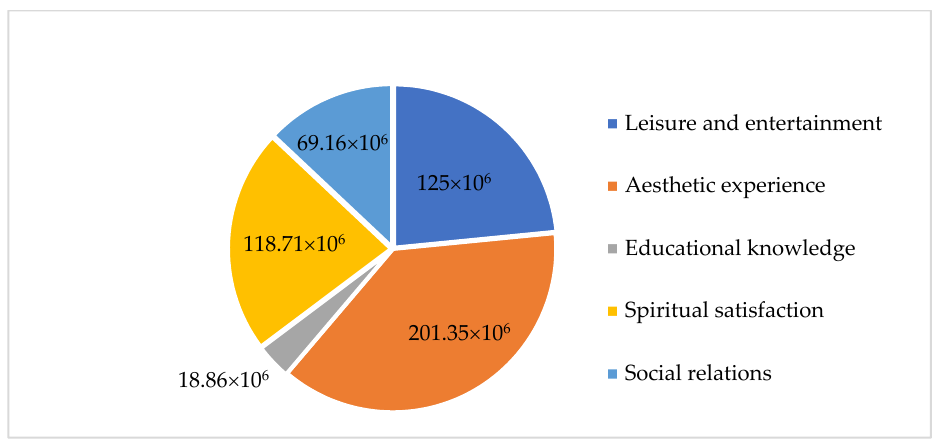
Figure 4. The multiple recreational and cultural services values in Changhai County (unit: USD).